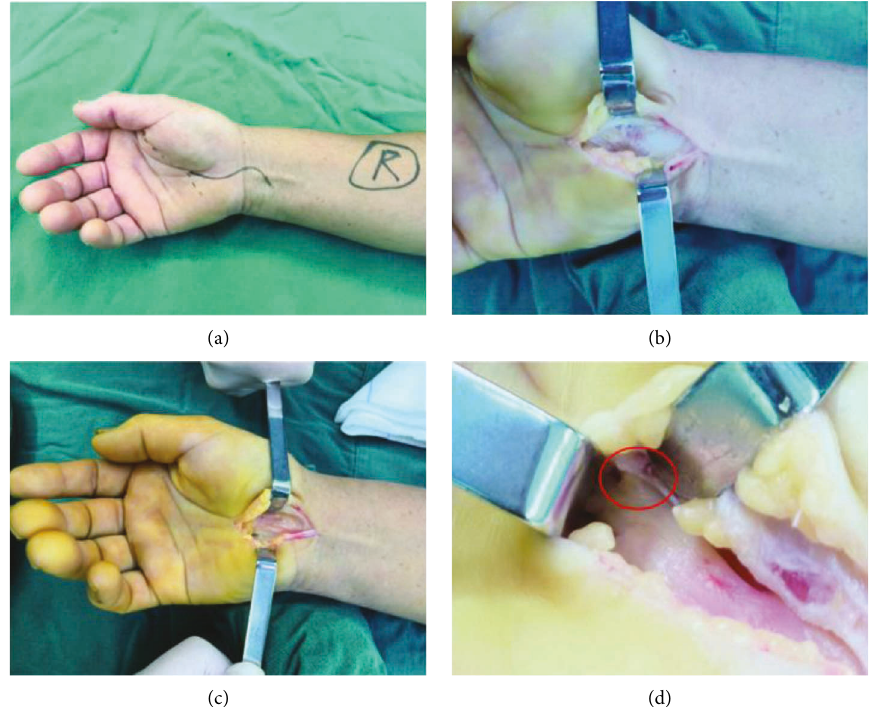
Figure 1: An “S”-shaped incision was made across the wrist of a length of approximately 6–8 cm (the dotted line is a Kaplan cardinal line and the solid line is an incisional site). (a) The incised skin was retracted, subcutaneous tissue and palmar aponeurosis were bluntly dissected using vascular forceps, and the transverse carpal ligament was exposed. (b) The ligament was cut with a surgical blade. (c) Exploration of the recurrent branch of the median nerve